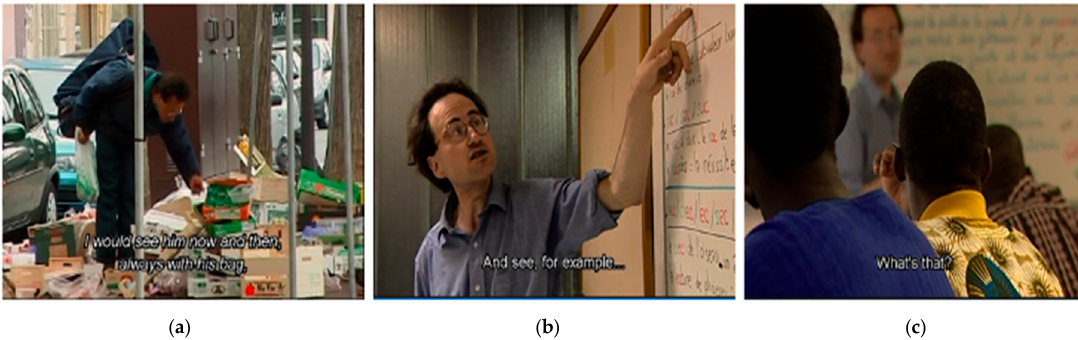
Figure 15. ( a ) Gleaning for vegetables after the market at Montparnasse; ( b , c ) Teaching French to fellow residents.